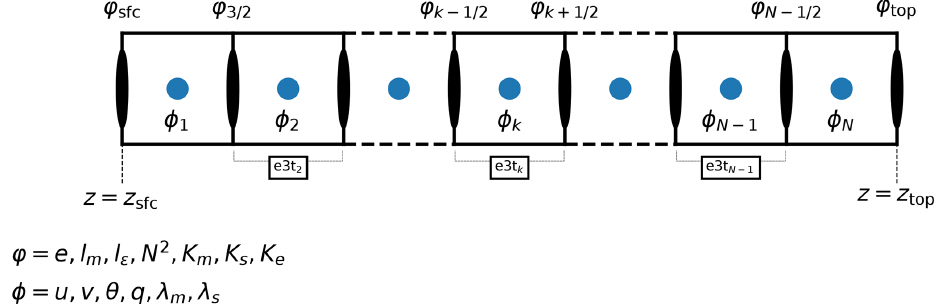
Figure 2. Vertical grid variable arrangements and important